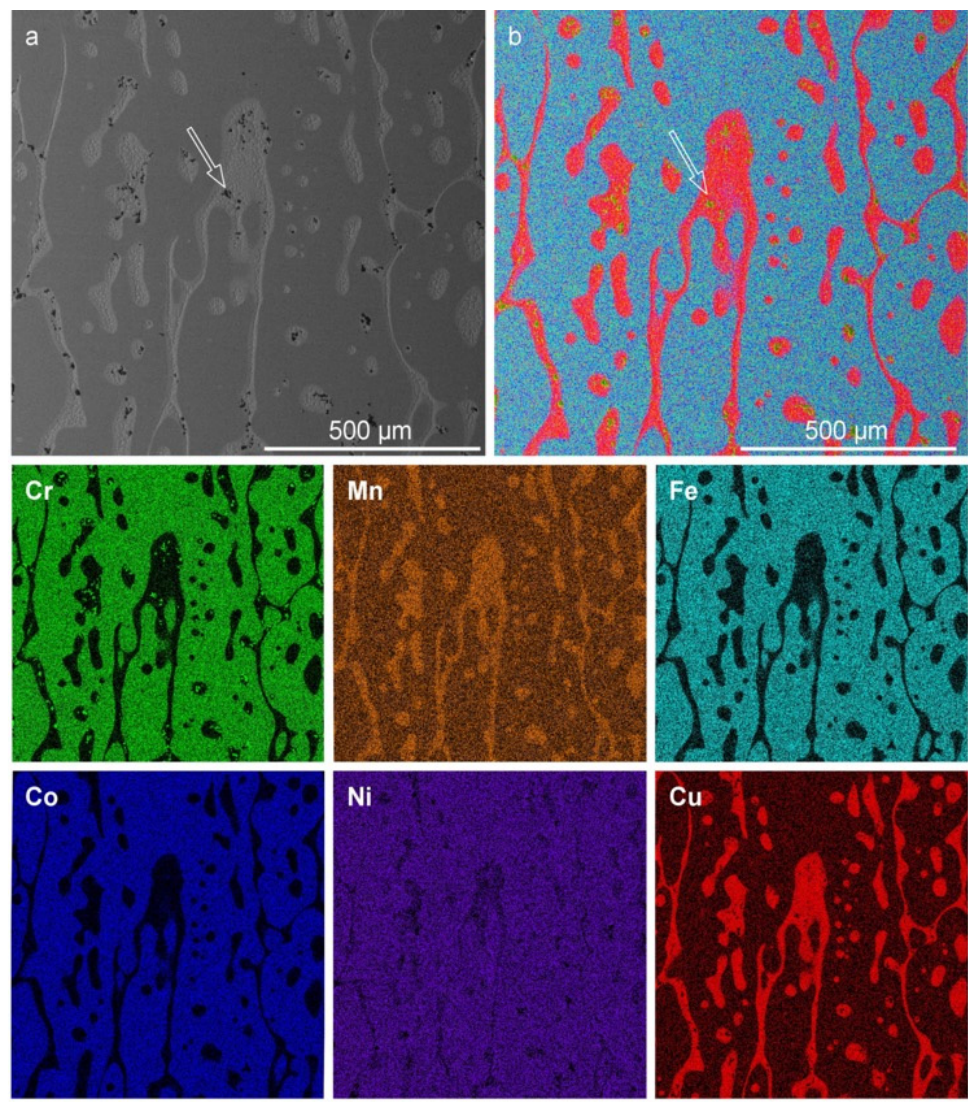
Figure 5. Morphology and elemental maps of the CrMnFeCoNiCu alloy after rolling and isothermal heat treatment. ( a ) Layered EDS map, ( b ) SEM micrograph, and constituent elemental maps of Cr, Mn, Fe, Co, Ni, and Cu, respectively. Arrows in ( a , b ) mark the presence of Cr-rich oxide inclusions. The spheroidal shape in combination with compositional fluctuations mimic a cored microstructure. The formation of a cored structure implies that the Cu-rich regions trans- formed to a liquid state during the heat treatment process, and subsequent cooling and solidification resulted in coring. This also implies that the alloy was in a state of simultane- ous solid and liquid. Given that the primary Cu-depleted phase remained compositionally constant while evolving morphologically, a monotectic reaction is expected. This is